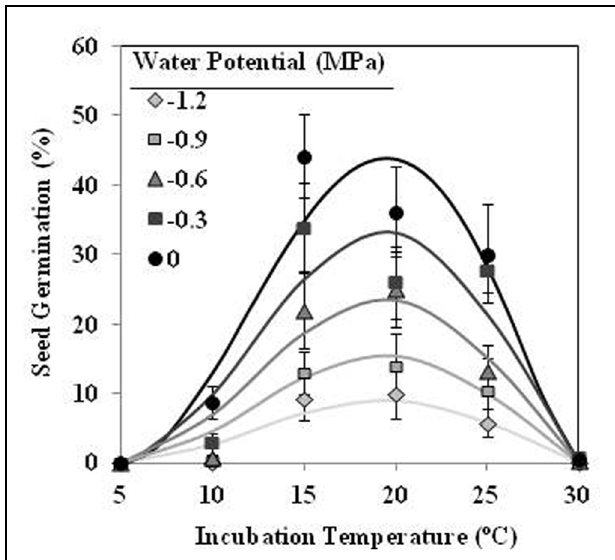
FIGURE 5 | Effects of temperature ( ◦ C) and water potential (MPa) on seed germination of O. crenata during incubation period. The lines were fitted according to Analysis β equation (Hau and Kranz, 1990; Table 1 ). Points represent the average of 12 repetitions. Bars represent the SD of the mean.